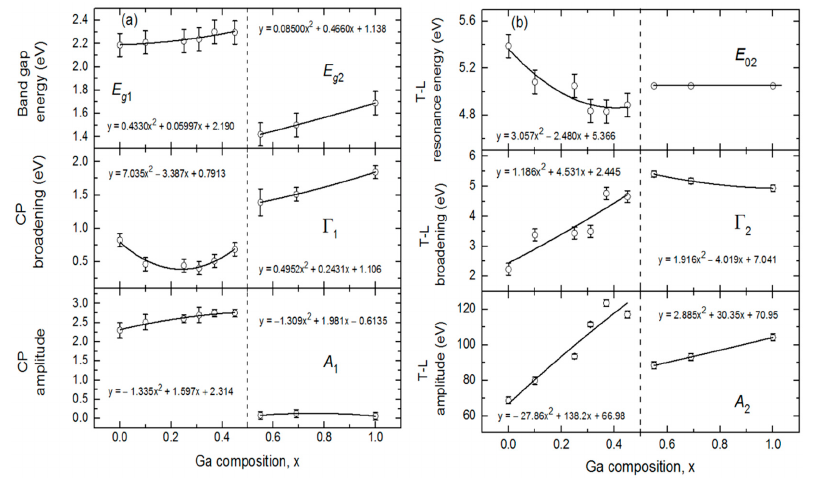
Figure 6. ( a ) (Top) Critical point (CP) resonance energy E g 1 ( x ≤ 0.45) or Tauc-Lorentz (TL) oscillator bandgap E g 2 ( x ≥ 0.56) as a function of the [Ga]/{[In] + [Ga]} atomic ratio ( x ) for IGS; (center) CP broadening parameter Γ 1 and (bottom) amplitude A 1 as functions of x . ( b ) (Top) The TL oscillator resonance energy ( E 02 ), (center) broadening parameter Γ 2 and (bottom) amplitude A 2 all plotted as functions of x . The TL oscillator resonance energy E 02 has been fixed to the value of 5.05 eV for Ga compositions x > 0.56 whereas it is allowed to vary for x ≤ 0.45. The constant contribution to the real part of the complex dielectric function ε 1, ∞ is fixed at unity throughout. These results are appropriate for an IGS temperature of 400 °C and a bulk layer thickness in the 3500–4100 Å range.